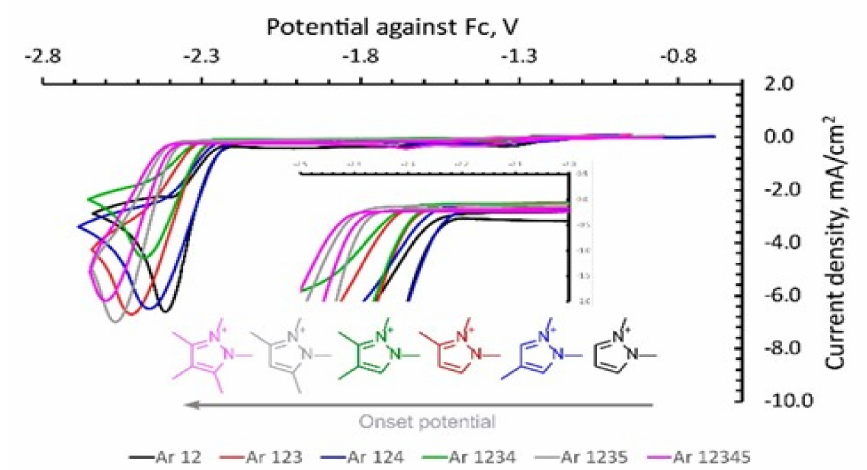
Figure 13. The CV values to illustrate the differences in the stability of several substituted Pz cations under Ar (Ag polished disk electrode, 0.1 M NBu 4 PF 6 in dry acetonitrile, and 0.02 M IL additive). Reprinted with permission from [88]. Copyright 2018 Chemical